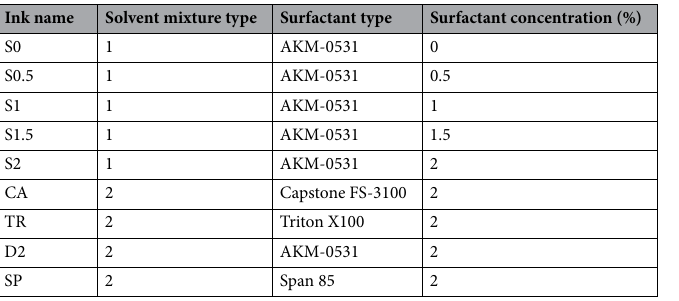
Table 1. Ink Samples for surfactant concentration test (S0-S2) and surfactant type test (CA, TR, D2, SP).